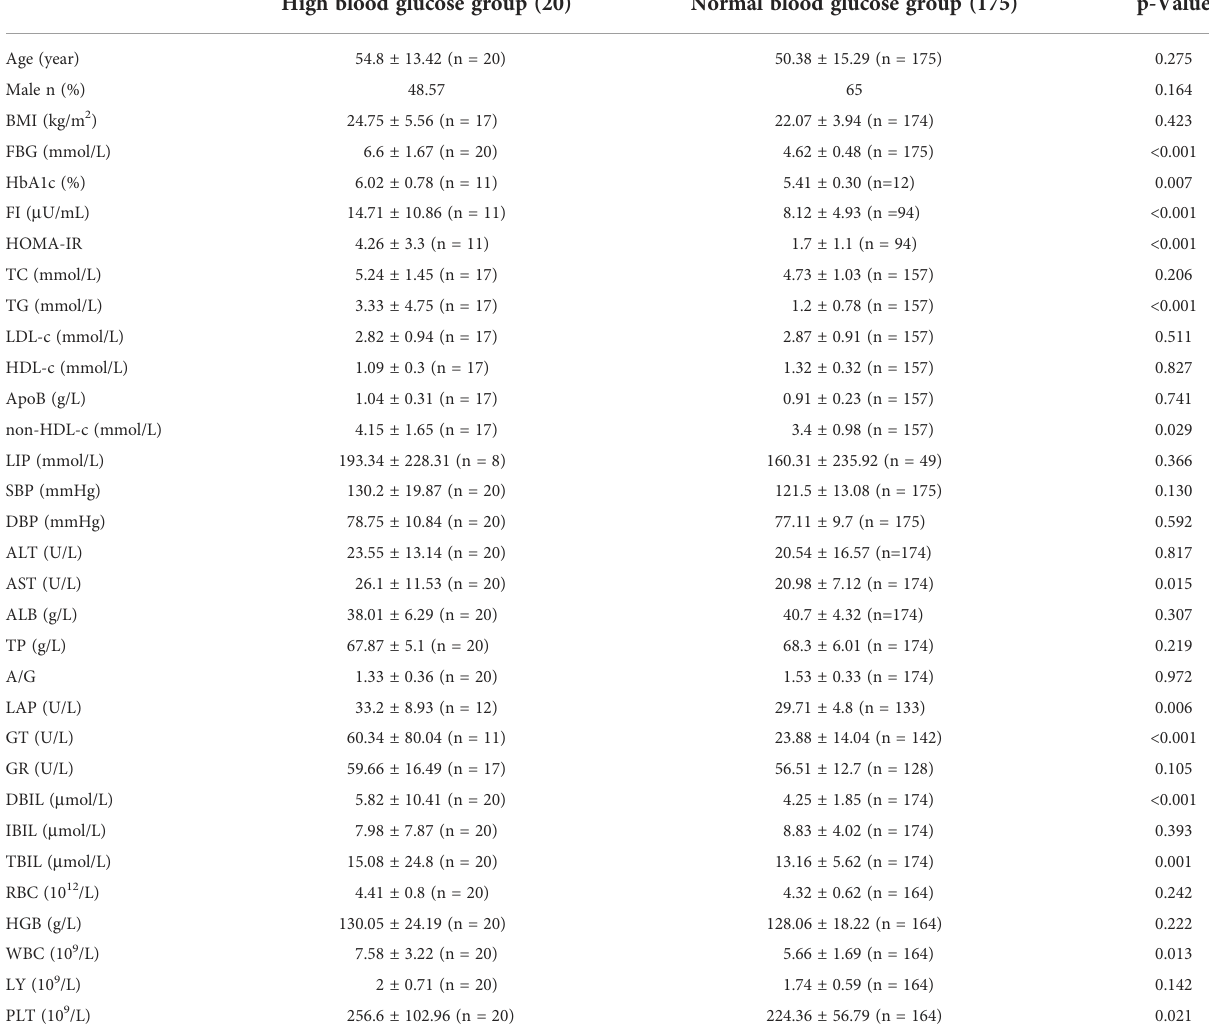
TABLE 2 Demographics and clinical characteristics of patients at